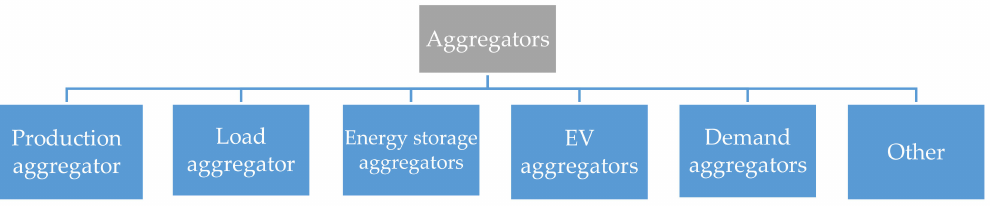
Figure 1. Types of aggregators